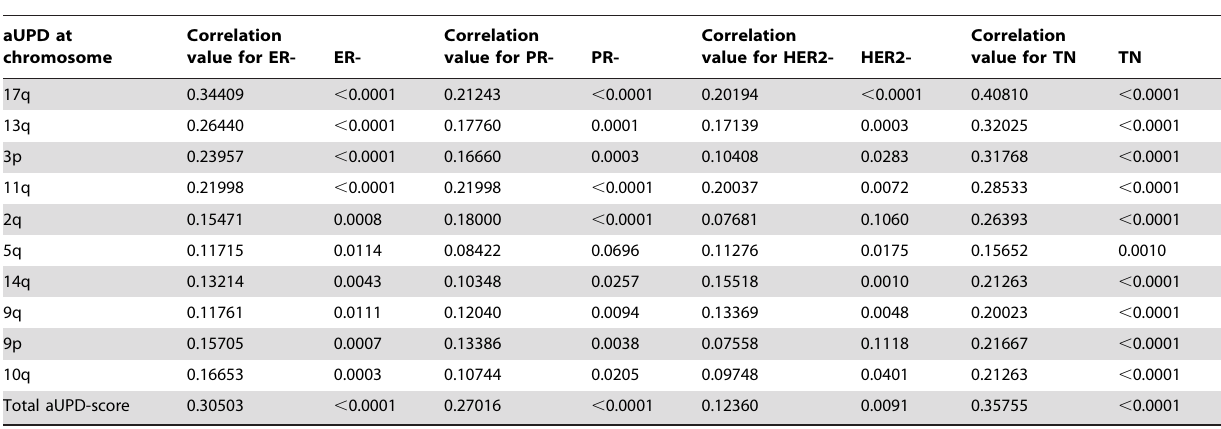
Table 1. Correlation between ER, PR and HER2/ neu status and aUPD regions.